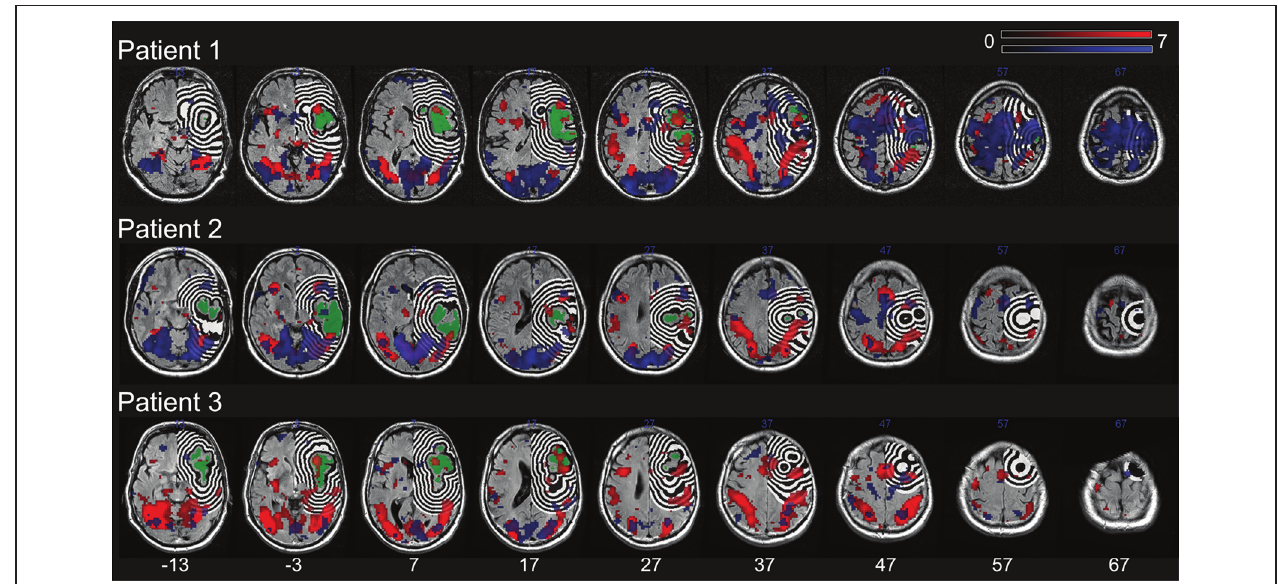
group of three control subjects assigned to the respective patient (red). The lesion shape, perilesional regions and the results of the statistical analyses are plotted onto the patients’ T2-FLAIR image. All images are in neurological orientation and a significance threshold of 0.05 FDR corrected for multiple comparisons was